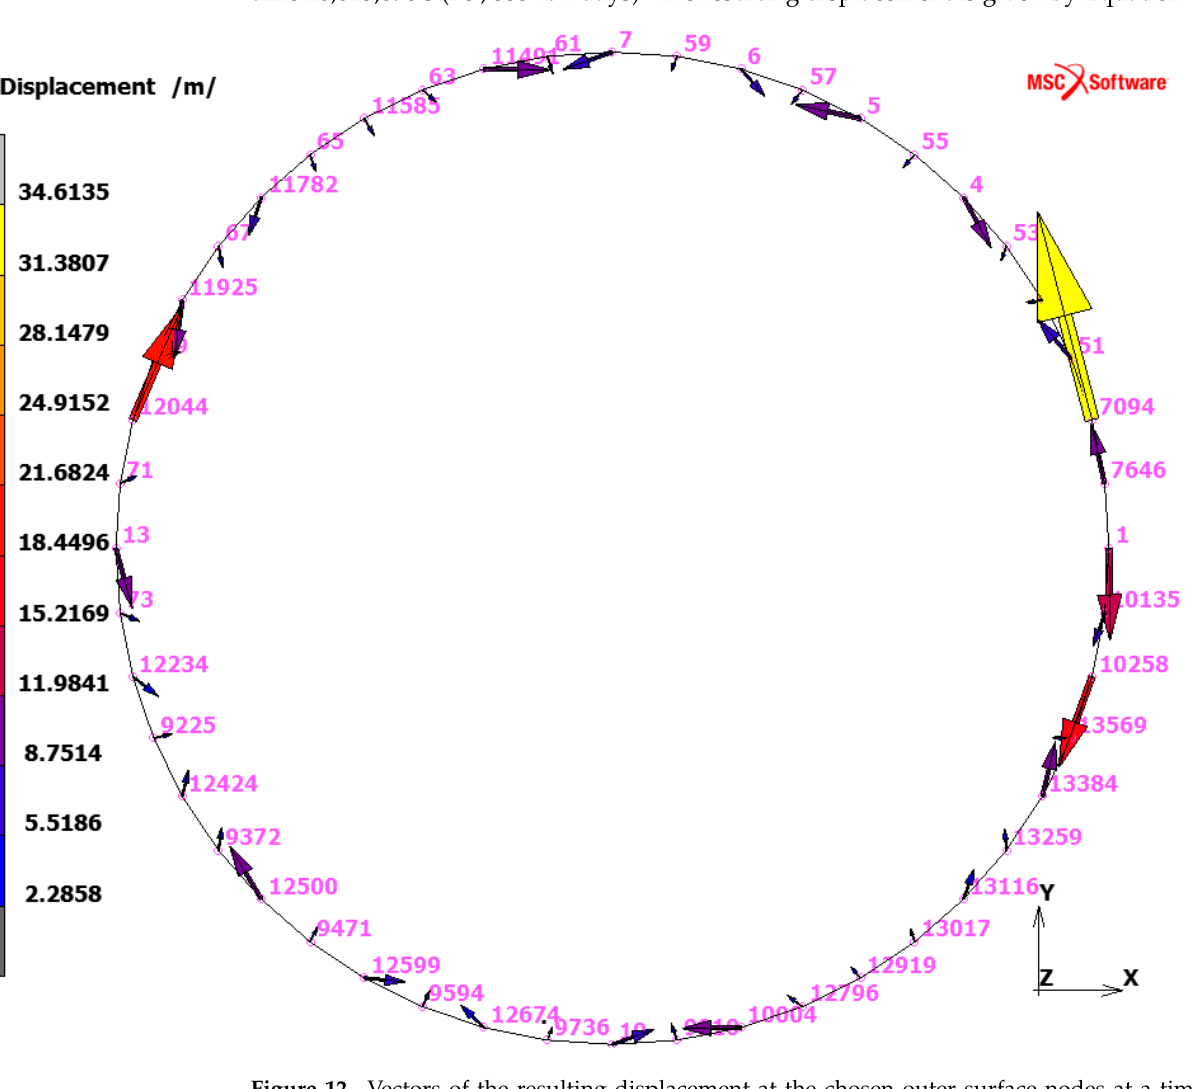
Figure 12. Vectors of the resulting displacement at the chosen outer surface nodes at a time of 28,813,890 s (i.e., 333.494 days), i.e., on 30 December 2008 with the numerical designation of the surface nodes.